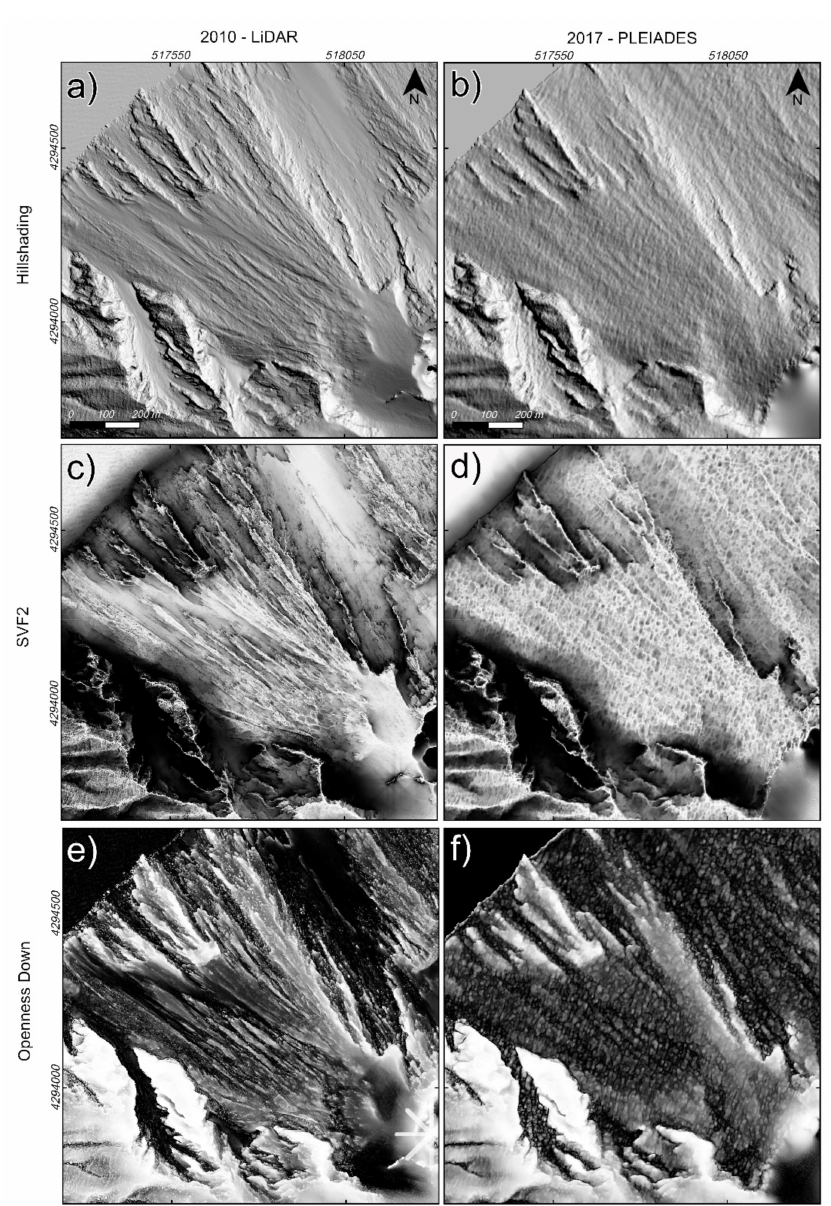
Figure 6. 2010 LiDAR DEM and 2017 PL É IADES DEM visual comparison of a west SdF sector. ( a ) Hill-shaded map, ( c ) sky view factor 2 map, and ( e ) openness down (crack map) image derived from the LiDAR DEM. ( b ) Hill-shaded map, ( d ) sky view factor 2 map, and ( f ) openness down map derived from the PL É IADES